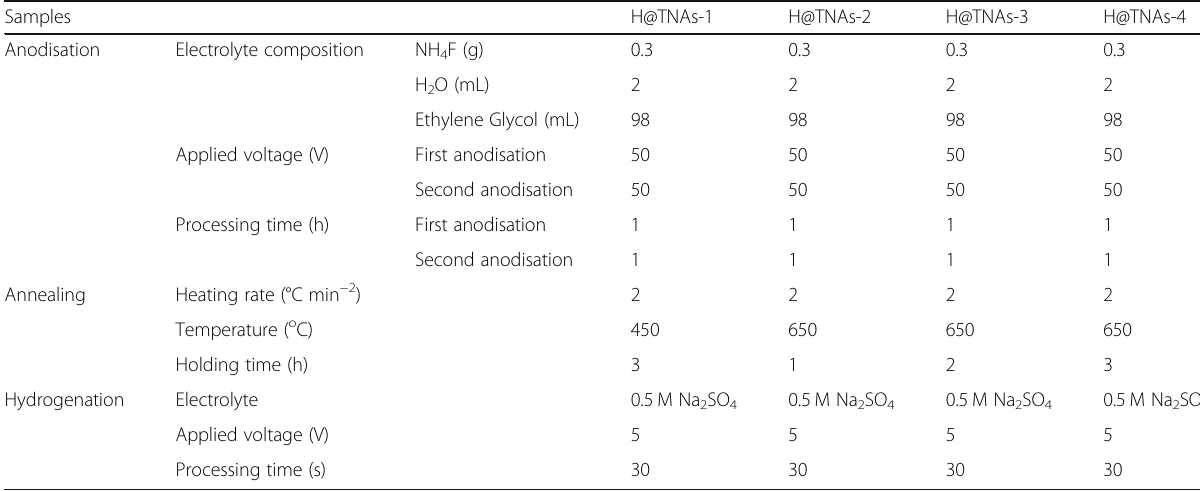
Table 2 Preparation parameters of samples Samples